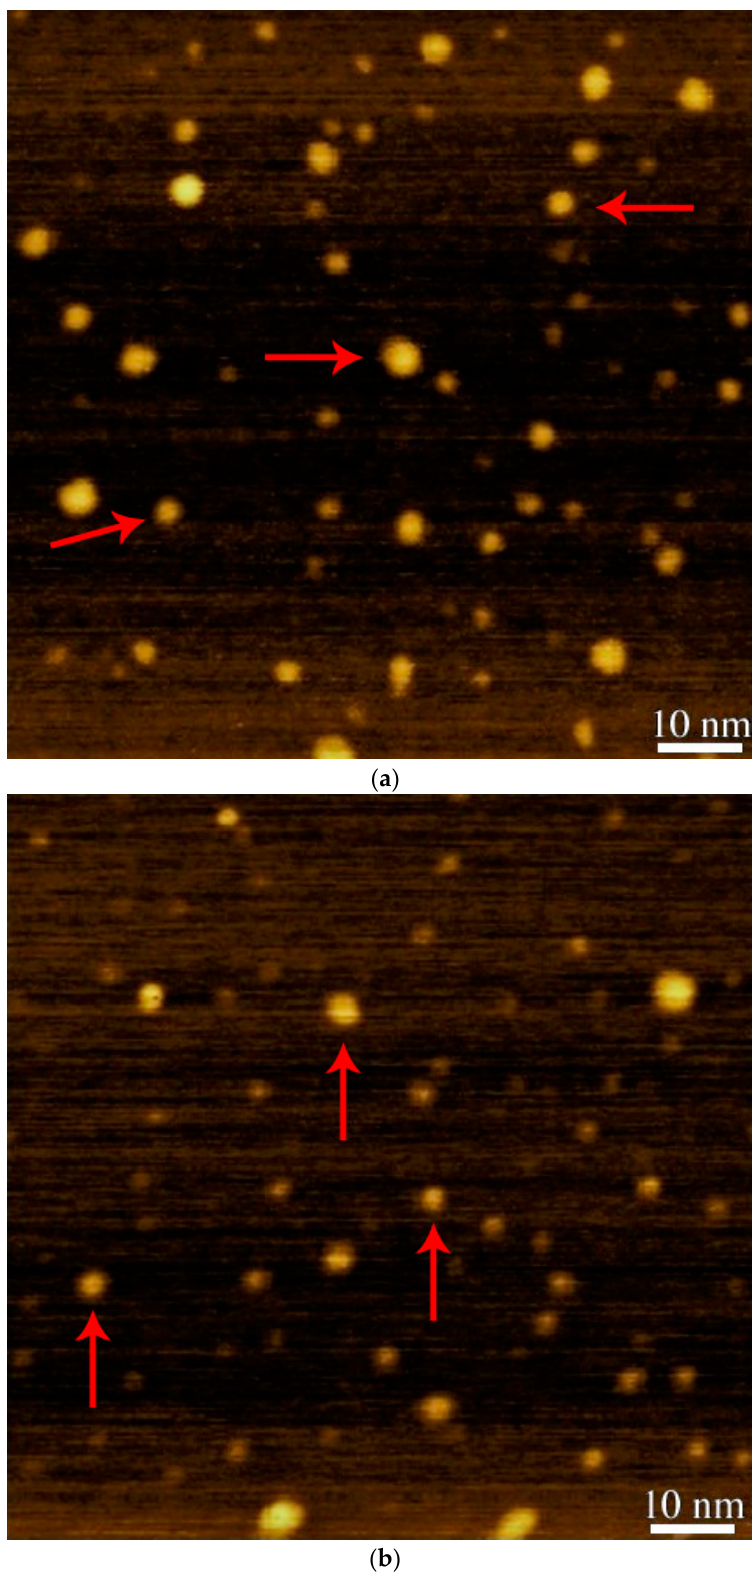
Figure 2. ( a ): AFM analysis of afzelechin conjugated silver nanoparticles. ( b ): AFM analysis of bare silver nanoparticles .